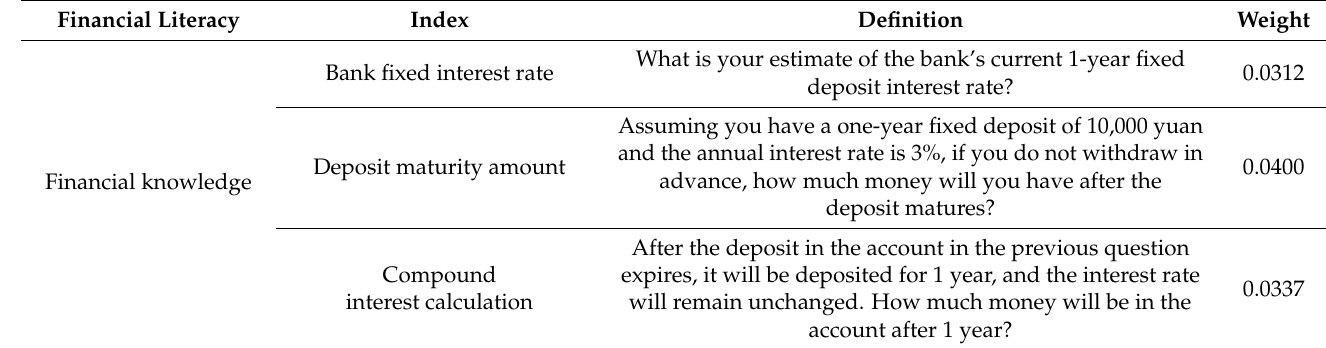
Table 2. Index system and weights of financial